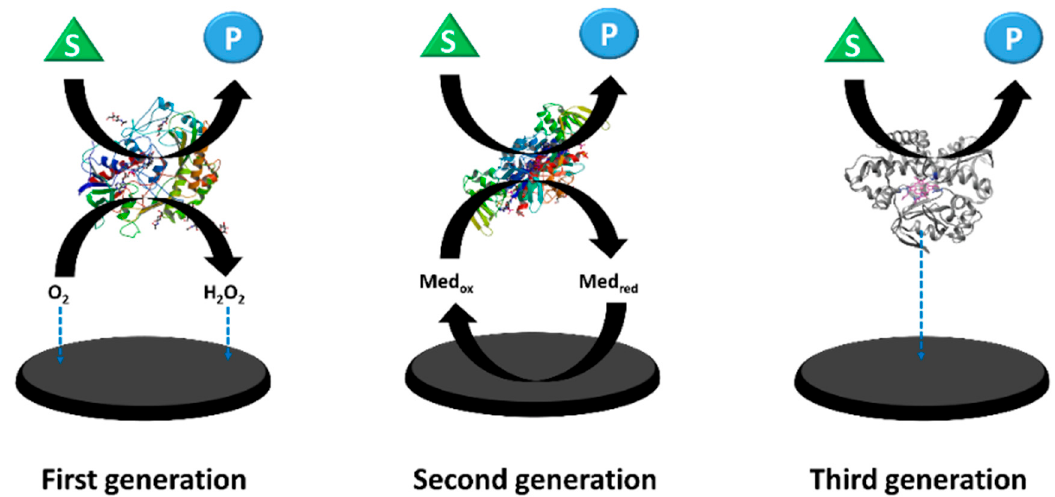
Figure 2. Schematic illustration of first-, second-, and third-generation amperometric enzymatic biosensors. First generation is based on the electroactivity of the receptor substrate or the product. Second generation is based on the use of artificial redox mediators. Third generation is based on the direct electron transfer between the redox-active biomolecule and the electrode. Adapted from [18].